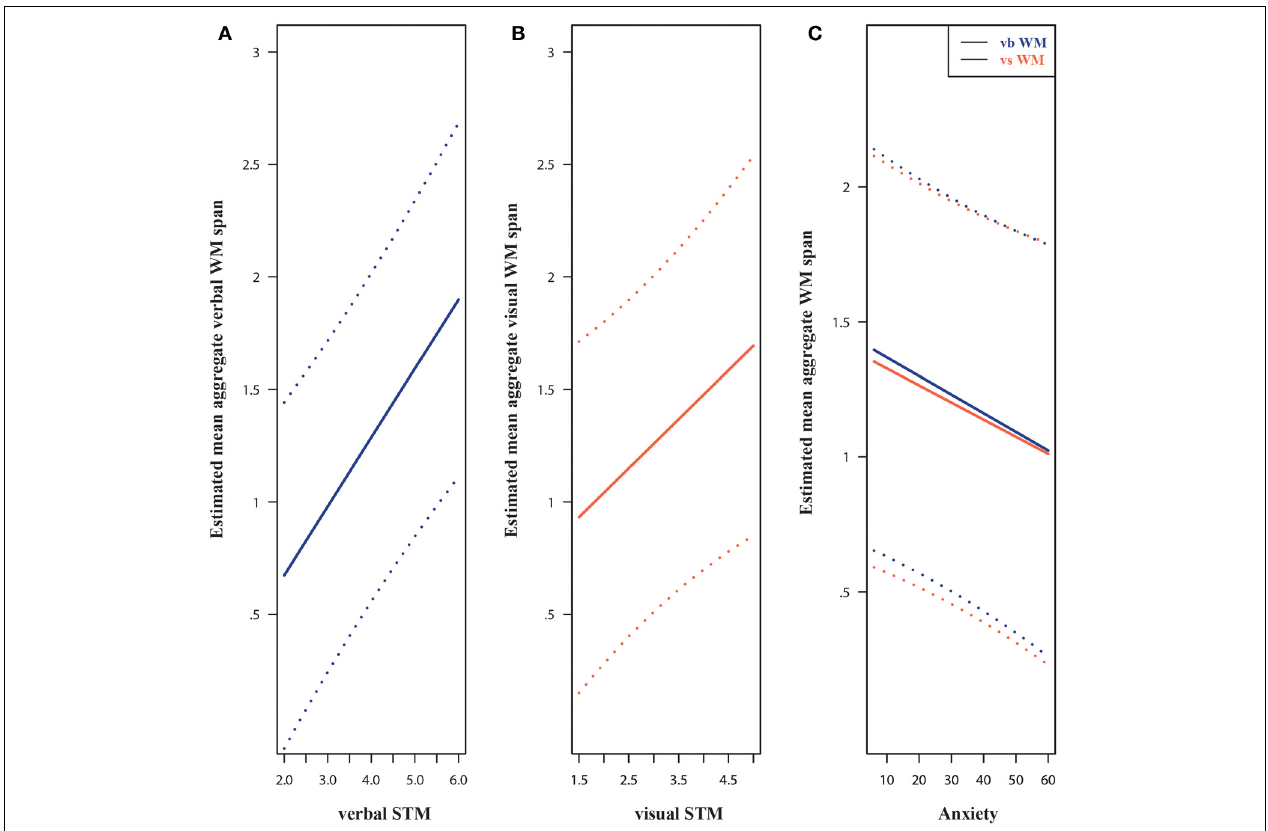
FIGURE 4 | Estimated regression lines and 95% Prediction Intervals for: verbal STM and verbal WM (A), visuospatial STM and visuospatial WM (B), and for trait anxiety and WM (C). Estimated means correspond to boys